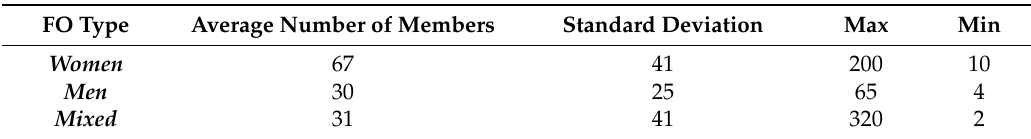
Table 3. Average number of members of the selected FOs.